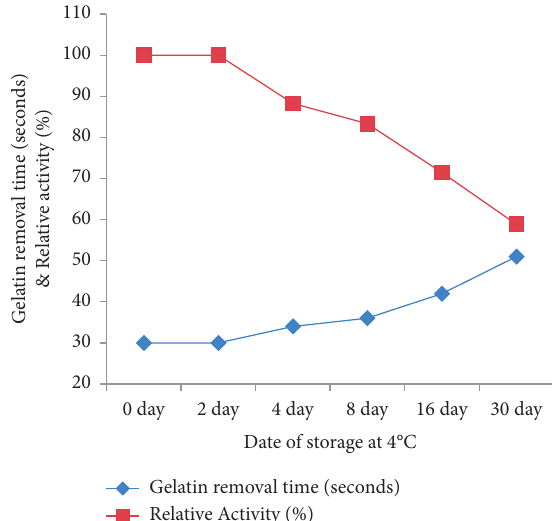
Figure 8: Active period of the enzyme after extraction was per- formed and kept at 4 °